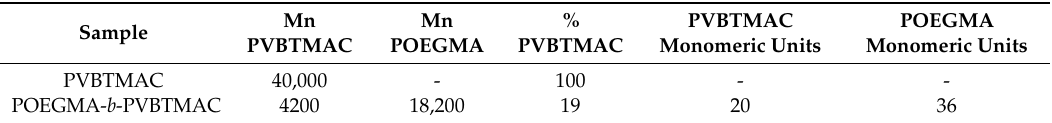
Table 1. Molecular characteristics of the PVBTMAC homopolymer and POEGMA- b -PVBTMAC copolymer.